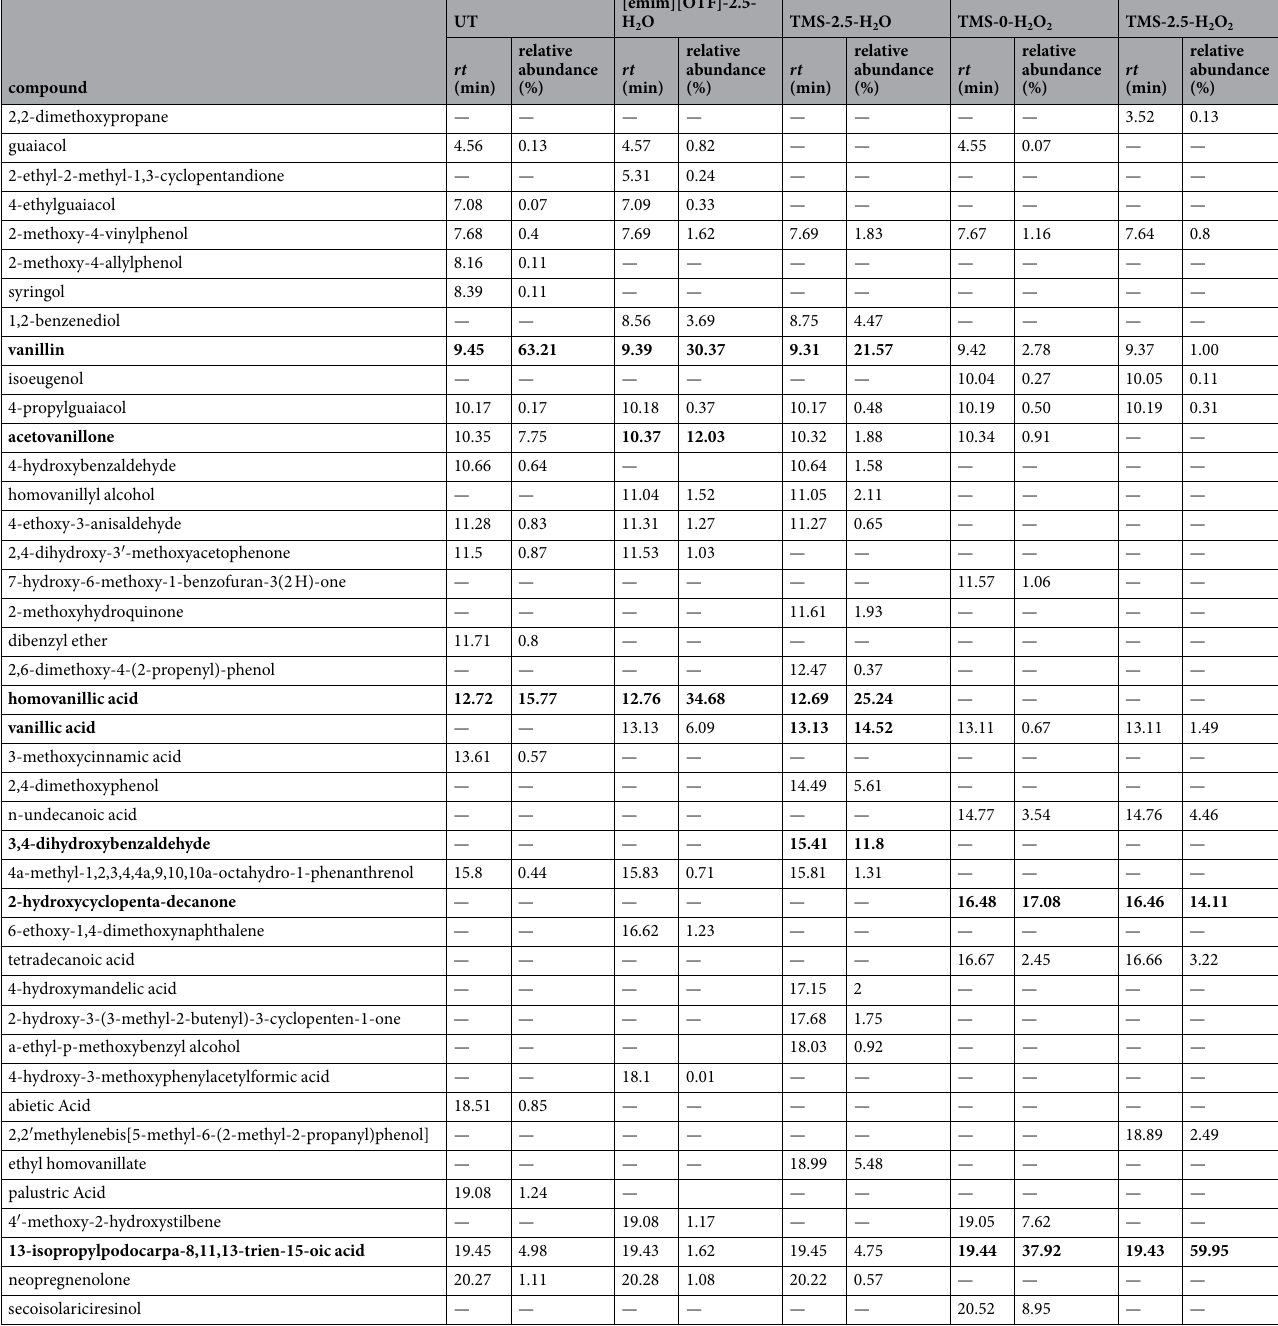
Table 3. Compound distribution within fraction 3 for each electrolyte system using GC-MS. Main components (relative abundance > 10%) are highlighted